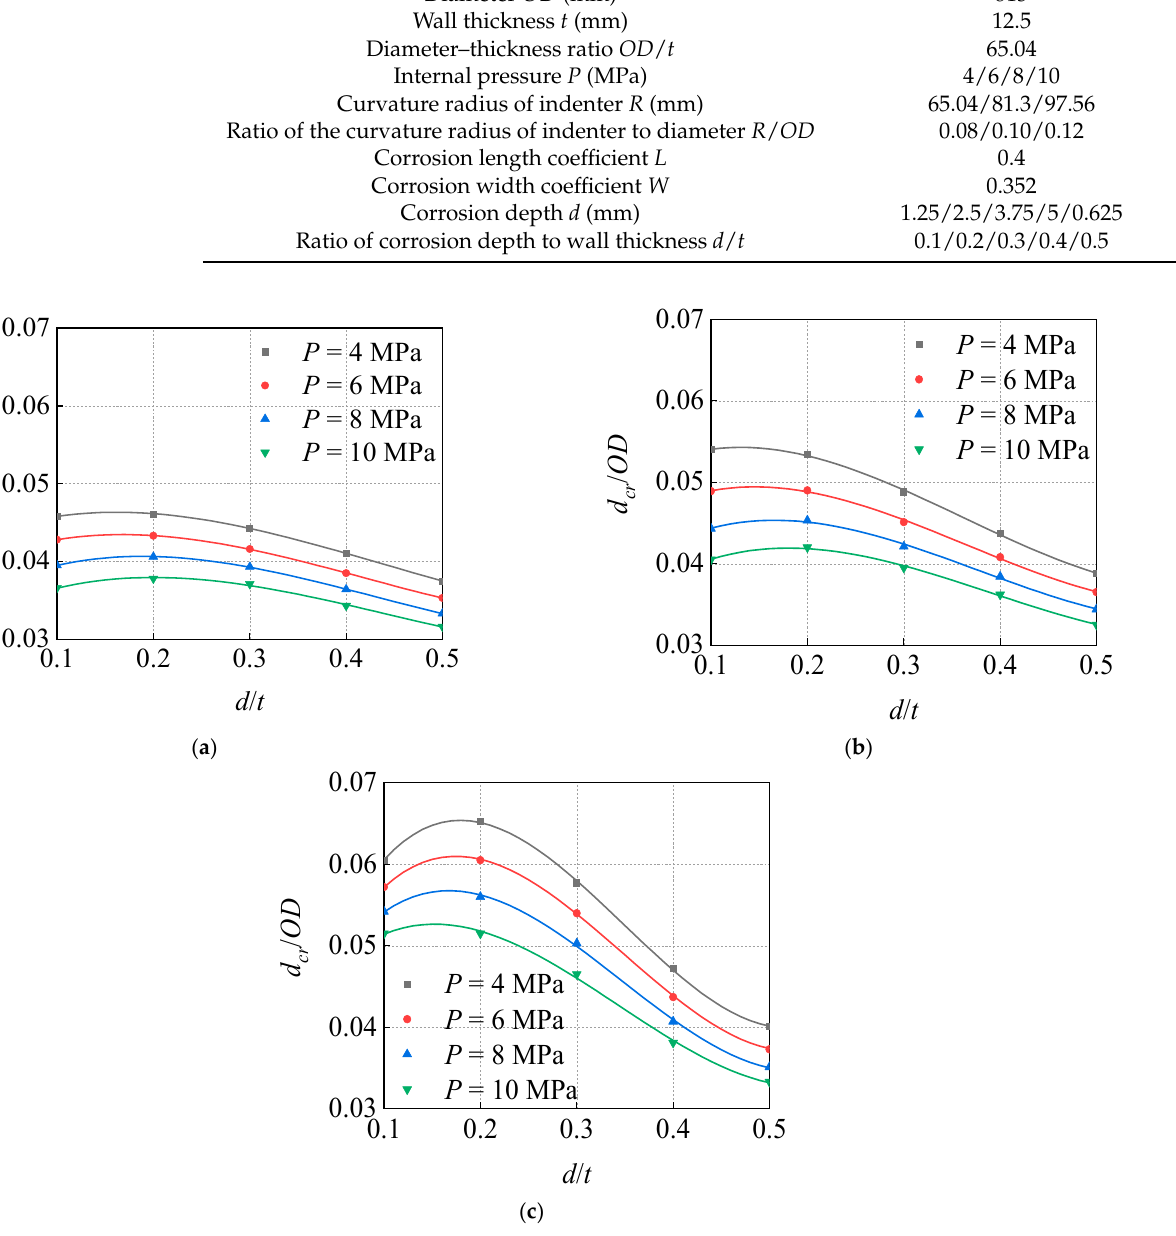
Figure 15. Influence of corrosion depth on critical dent depth under different pressure: ( a ) R / OD = 0.08, ( b ) R / OD = 0.10, ( c ) R / OD = 0.12.